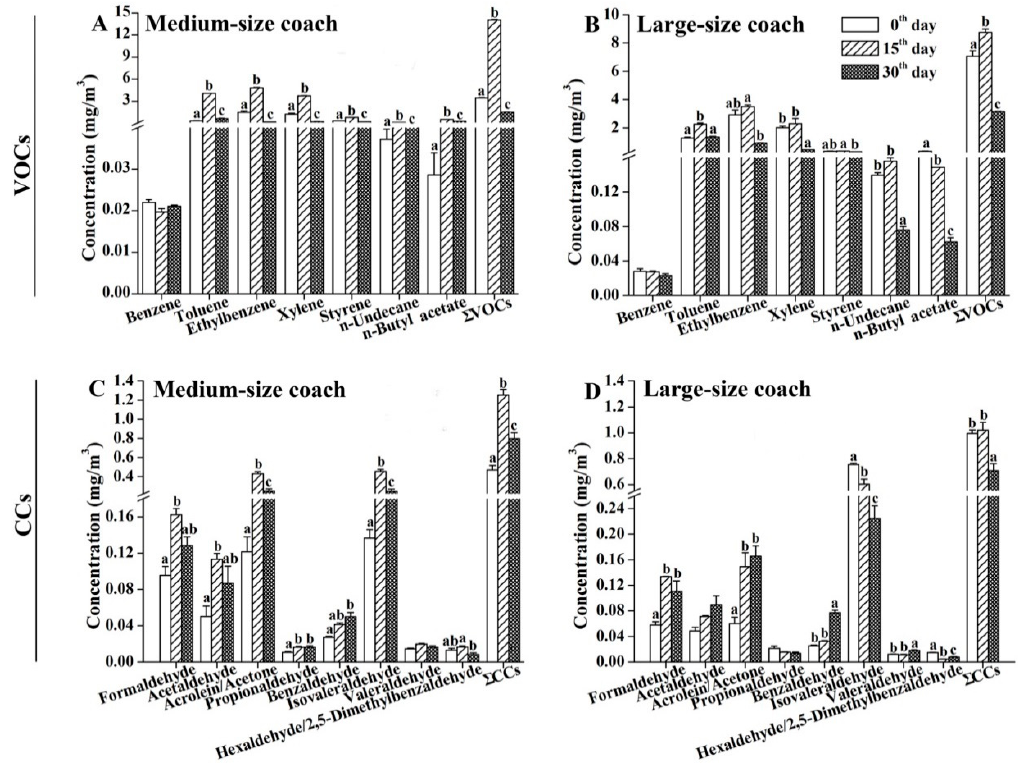
Figure 3. The emission amounts and characteristics of the organic compounds in the medium- and large-size air-conditioned coaches. Air samples were collected on the 0th, 15th, and 30th day after coming off the assembly line, respectively. Interior temperature: 25 ± 2 °C. Interior relative humidity: 50% ± 10%. ( A , B ) Levels of VOCs in the tested air samples; ( C , D ) Levels of CCs in the tested air samples. The results are expressed as the mean ± SEM. Values labeled with different letters are significantly different from each other at p < 0.05.